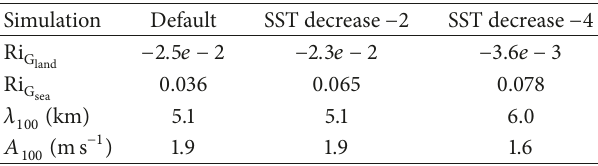
Table 5: Stability and roll characteristics from simulations using different SSTs.